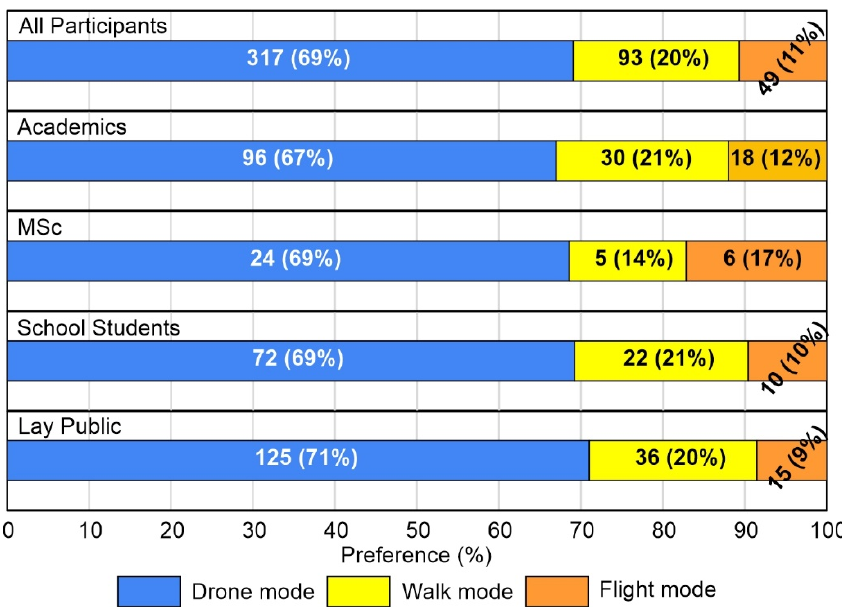
Figure 9. Bar charts showing the preferred navigation mode. The results represent both the total number of participants and the background of each group respectively.